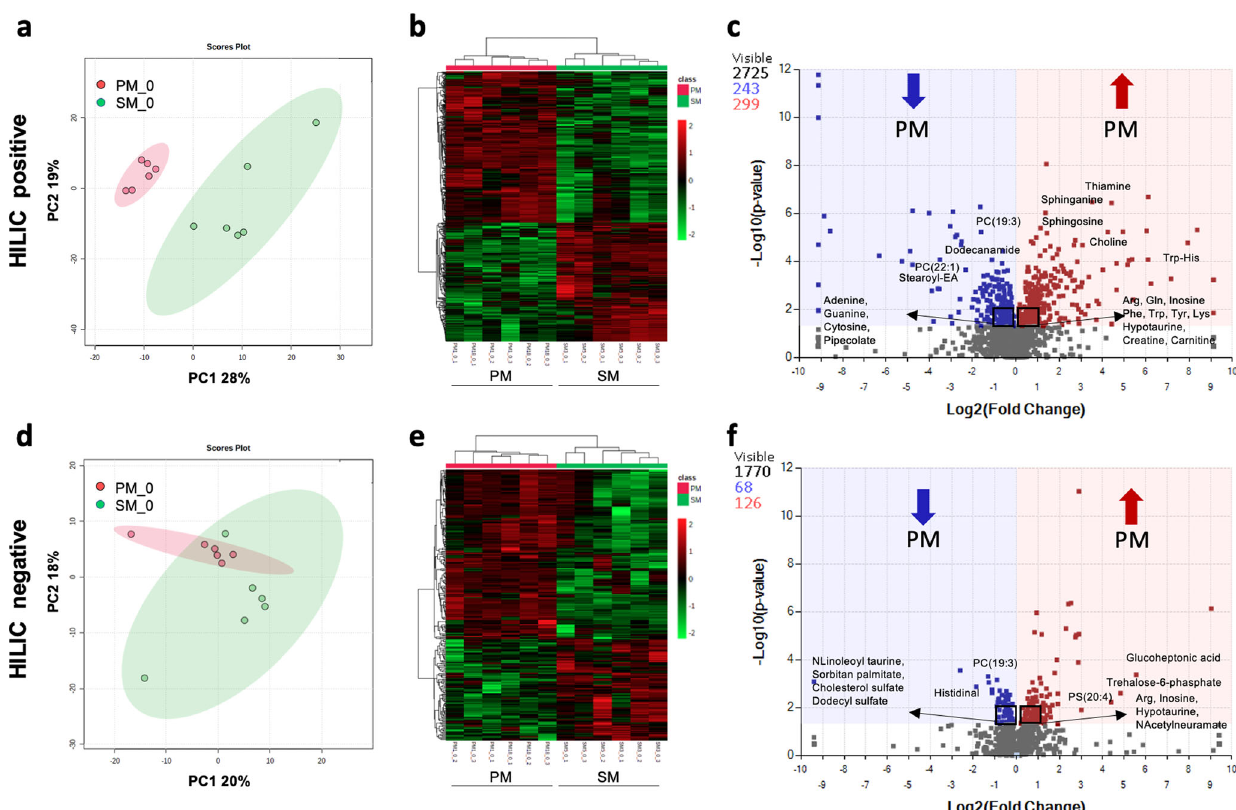
Fig. 6 The metabolome of SM and PM neural precursors show signi fi cant differences. The metabolome of SM and PM day 11 neural precursors resulting from three separate differentiations (1 – 3) were analyzed by HILIC positive mode ( a – c ) and HILIC negative mode ( d – f ) mass-spectrometry. a . d Principal component analysis (PCA plots) illustrates distinct metabolomic pro fi les for PM vs SM. b , e Hierarchical clustering maps provide global comparisons for PM vs SM differences of the top 500 signi fi cantly different individual metabolite levels (rows) clustered by SM and PM cell lines and differentiations (columns). Metabolites are colored according to relative feature abundance across all samples ranging from low (green) to high (red). c , f Volcano plots illustrate the total number of detected metabolites (gray) and signi fi cantly increased (red) or decreased (blue) metabolites in PM vs SM ( p < 0.05). A total of 2725 (HILIC pos) and 1,770 (HILIC neg) compounds were detected of which 542 (HILIC pos) and 194 (HILIC neg) are signi fi cantly different between PM vs SM. Representative members of the identi fi ed pathways (Fig. 7) altered between the two brothers are highlighted. Some of the most signi fi cantly changed molecules cannot not be annotated, because there are too many isomers as possible candidate